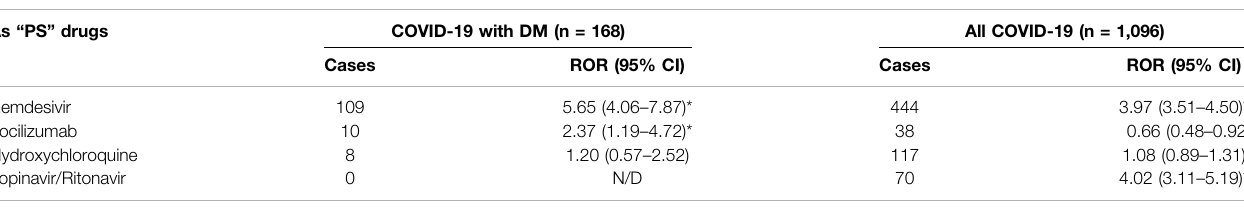
TABLE 2 | Disproportionality analyses for AKI upon the use of drugs prescribed for COVID-19. As “ PS ”